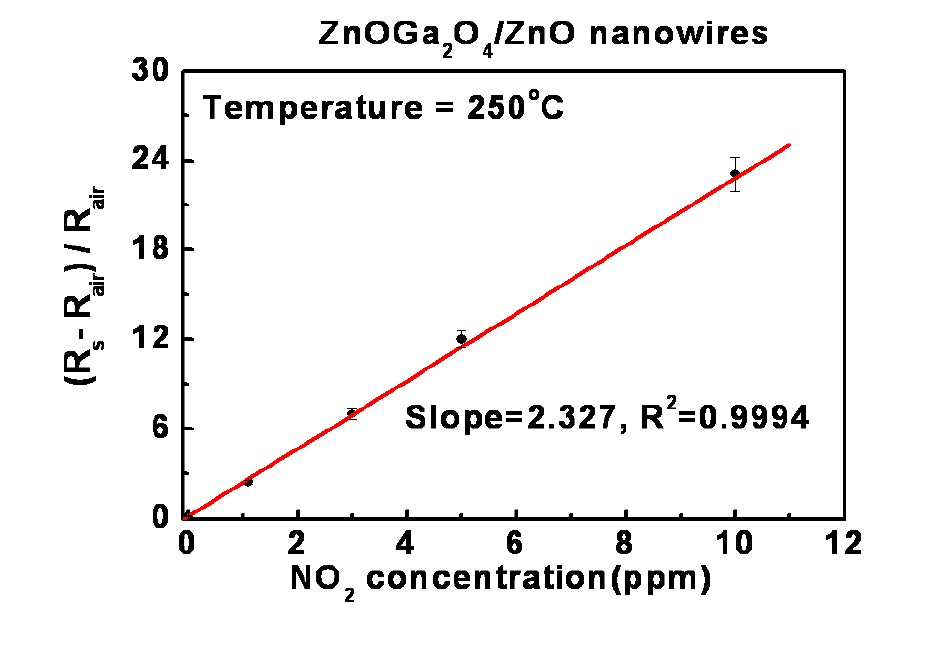
Figure 6. Response calibration of ZnGa concentrations at 250 NO 2